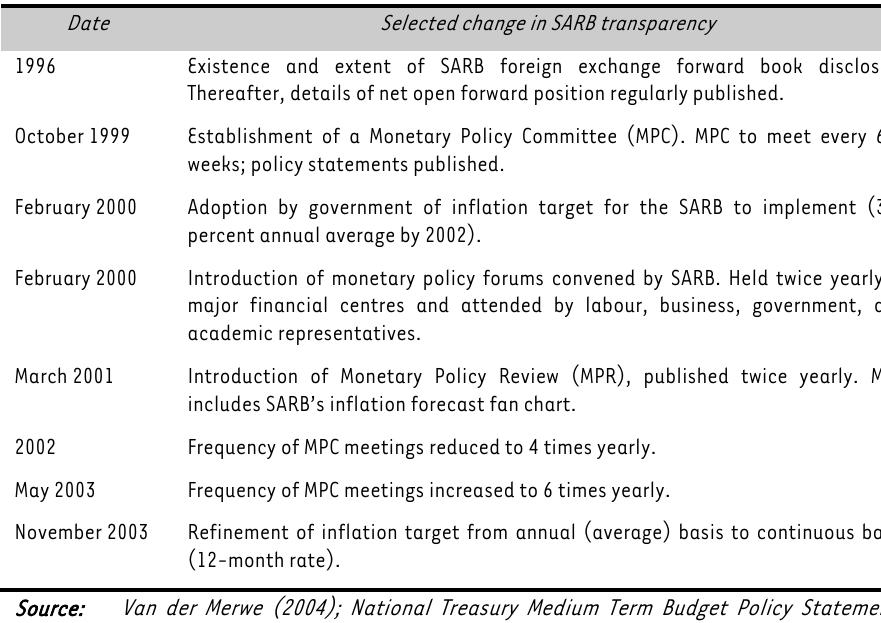
TABLE 1: Selected changes in SARB transparency,